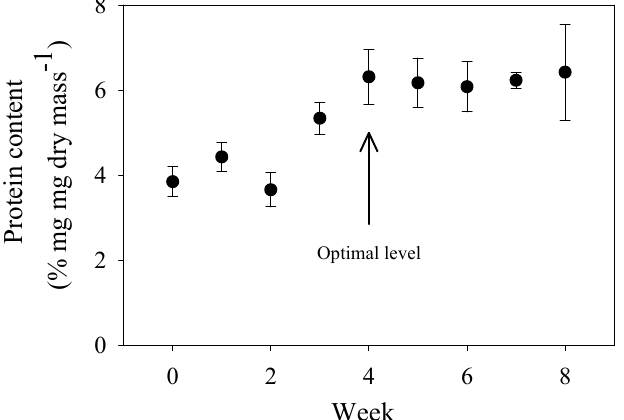
Figure A1. Protein content (mean ± 2 S.E.; N = 6–10) of elm ( Ulmus americana ) leaf disks submerged in 0.3-mm mesh bags for various lengths of time in Ell spring during June-August 1992. Protein content was determined by a Bio-Rad (Bradford) protein assay using bovine serum albumin as a standard. Increased protein content is a good indicator of microbial and fungal growth (“conditioning”) because microbes and fungi have a high protein content, whereas dead leaves have a very low protein content. Similar increases in protein (nitrogen) content during detrital leaf conditioning have been observed in other studies (e.g., [181], and other references cited in [86]). The arrow indicates the optimal level of protein content, which represents the highest level achieved over the shortest culture time. Therefore, leaf disks that had been conditioned for 4 weeks were used in the laboratory assimilation study.